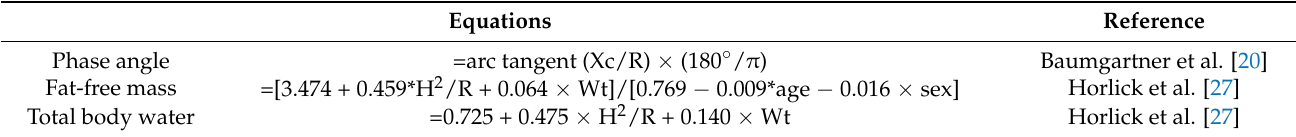
Table 1. Predictive equations used in the present study. Equations